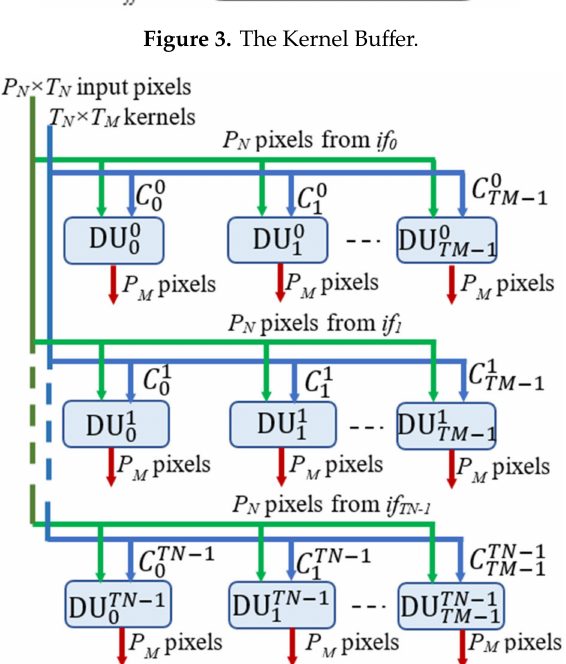
Figure 4. The architecture of the novel Deconvolution